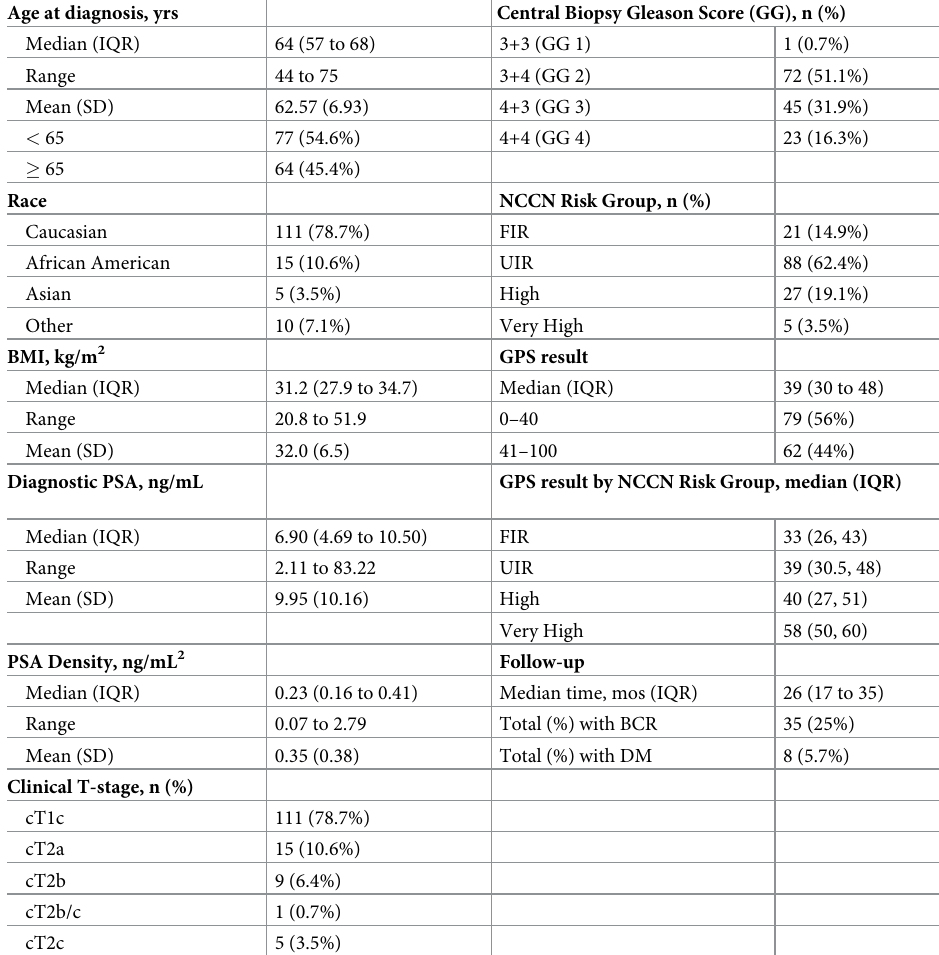
Table 1. Patient